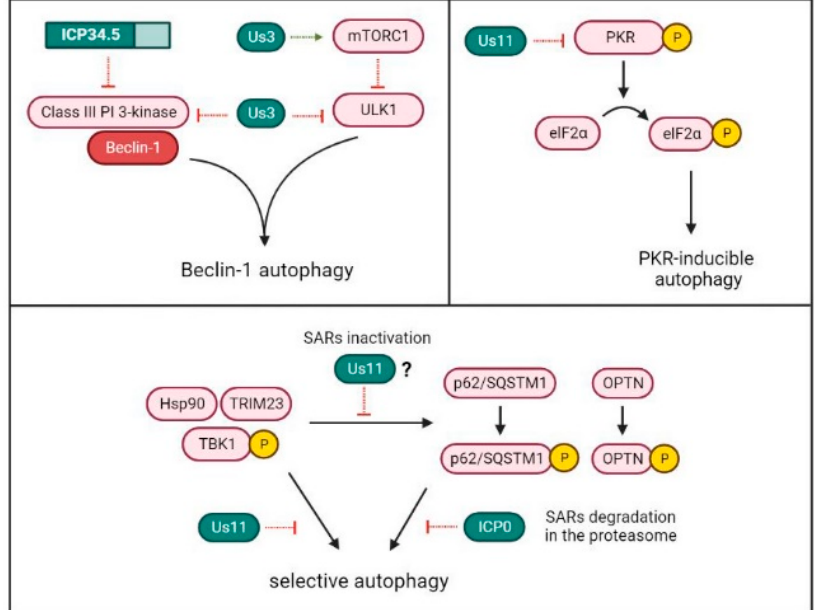
Figure 5. HSV-1 mechanisms for autophagy inhibition. HSV-1 proteins Us3 and ICP34.5 can inhibit macroautophagy by binding to Beclin-1, which is required for autophagosome formation. Us3 can also suppress the pathway by the activation of the negative regulator of autophagy mTORC1 or by the inactivation of the ULK1 complex, which is involved in phagophore initiation. The HSV-1 protein Us11 can prevent the induction of autophagy mediated by the PKR/elF2 α pathway. Besides, Us11 inhibits virus-induced autophagy by the disassembly of the TRIM23-Hsp90-TBK1 complex. Finally, the HSV-1 protein ICP0 promotes the degradation in the proteasome of the selective autophagy receptors p62/SQSTM1 and OPTN, which are implied in the recruitment of HSV-1 in autophagosomal membranes. The TRIM23-TBK1 complex is involved in the phosphorylation and activation of these selective receptors. However, the inhibitory role of Us11 on the TRIM23-TBK1 complex has not been directly associated with a possible SARs inactivation.